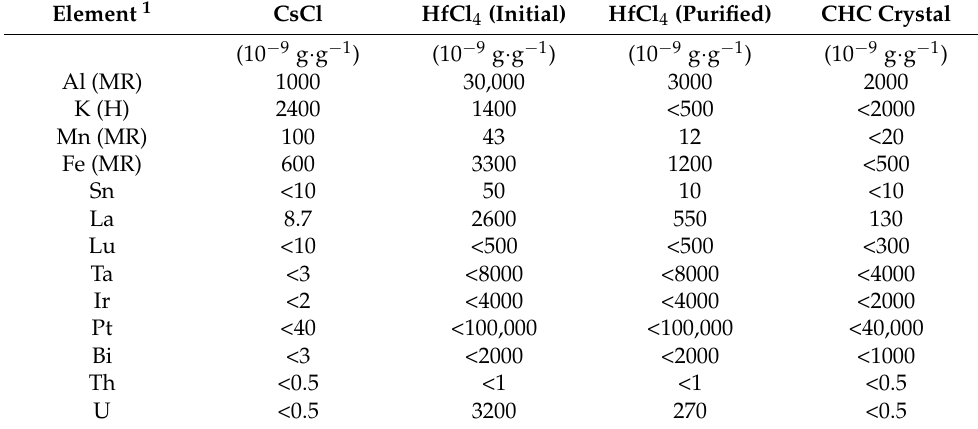
Table 1. Some elements monitored by inductively coupled plasma mass spectrometry (ICP-MS). The values are expressed in 10 − 9 g · g − 1 . The uncertainty is ± 30% of the given result.